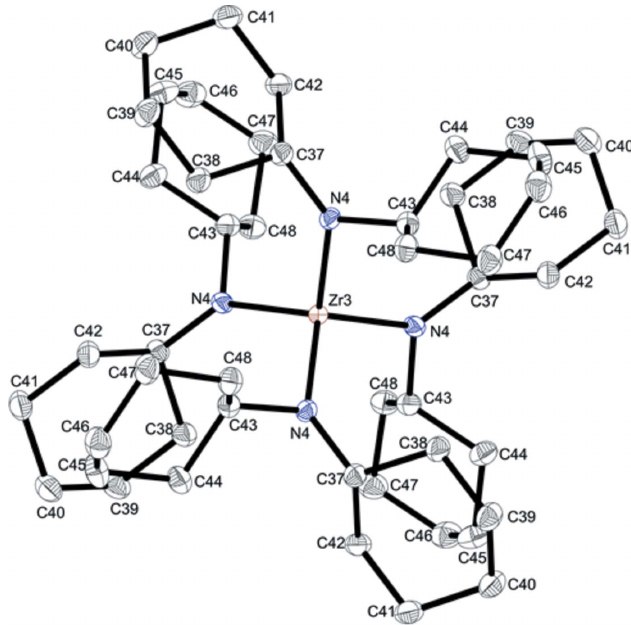
Figure 1 Representative for the three different molecules of 1 in the asymmetric unit, the molecular structure of complex Zr3 is displayed. Displacement ellipsoids correspond to the 50% probability level. H atoms have been omitted for